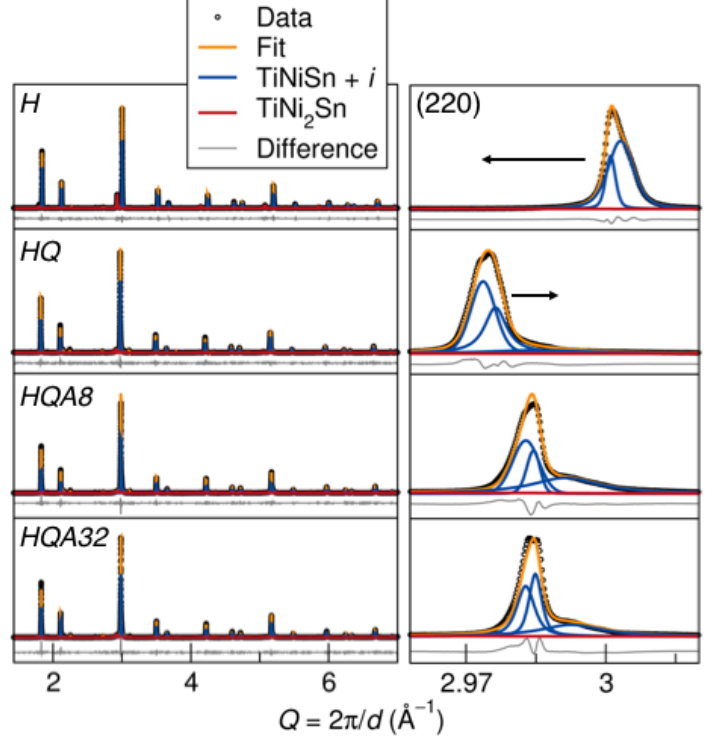
Figure 3. Rietveld refinement of synchrotron X-ray diffraction data for each sample, showing